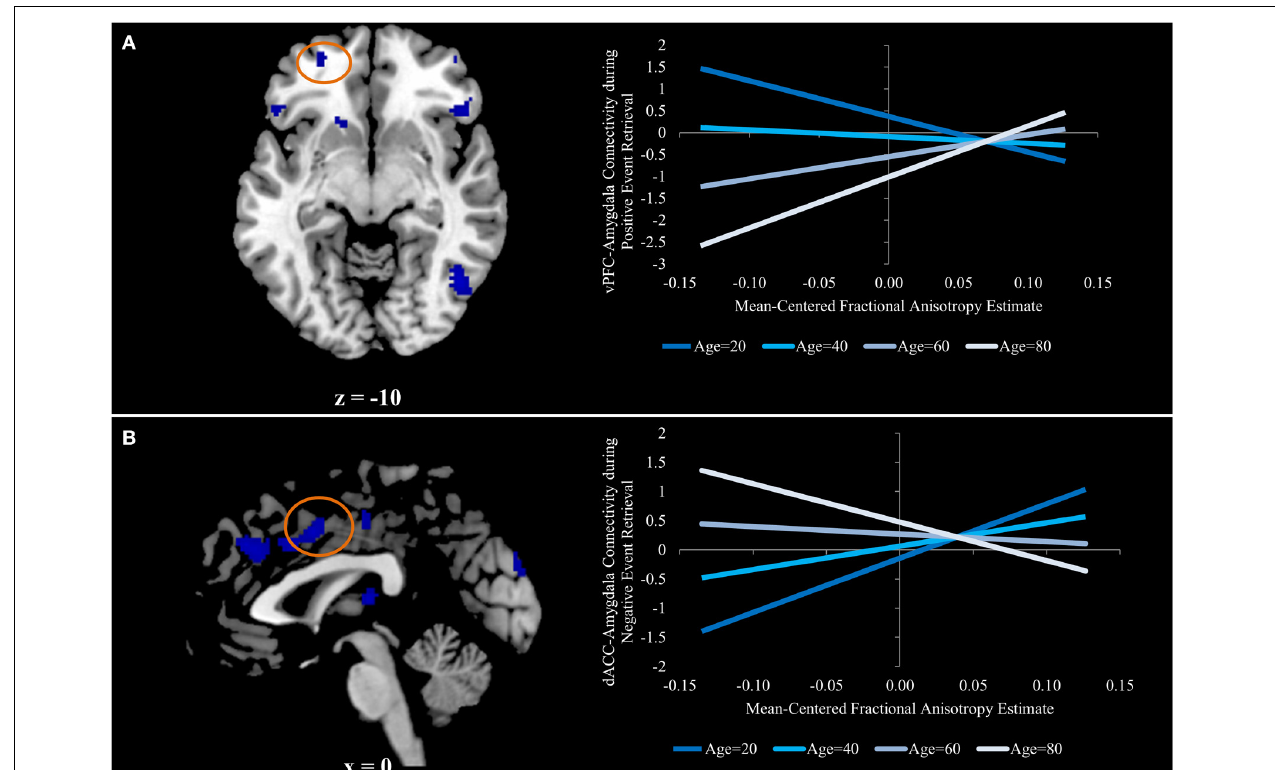
FIGURE 3 | (A) Ventral prefrontal region in which aging is associated with an increased relation between functional and structural connectivity for positive event retrieval, but not during negative or neutral event retrieval. (B) Dorsal anterior cingulate region in which aging is associated with a stronger negative